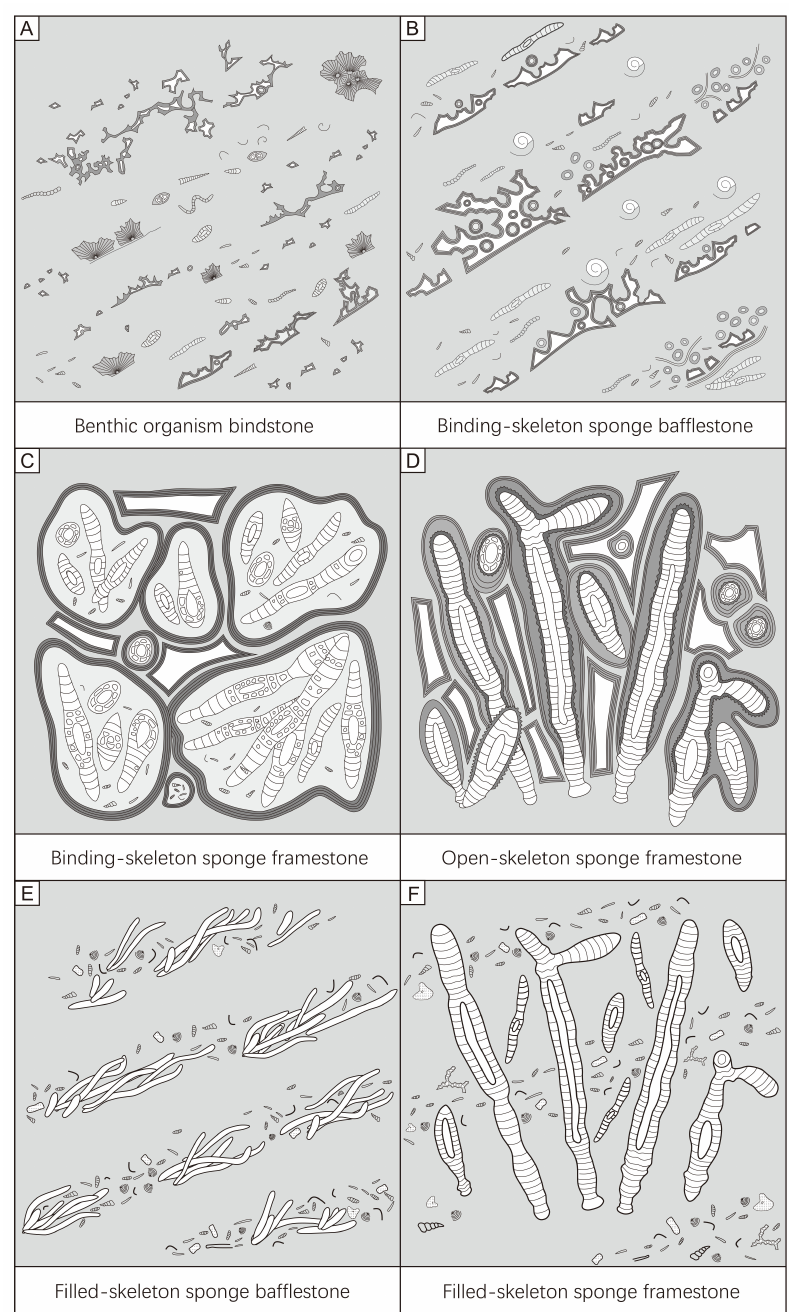
Figure 11. The model of the reefal lithofacies pattern. ( A ) benthic organisms bindstone: The algae and calcite cement bound and encrusted benthic organism fauna and formed